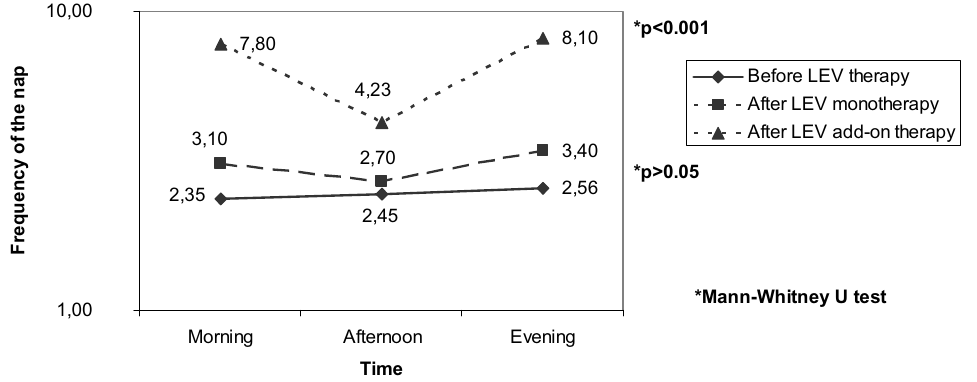
Fig. 2. Distribution of the nap episodes by time. Nap episodes generally appeared to be related to the LEV administration. Perhaps, owing to this characteristic of napping episodes, sleep latencies in the post-treatment group are shorter than those in the pre-treatment